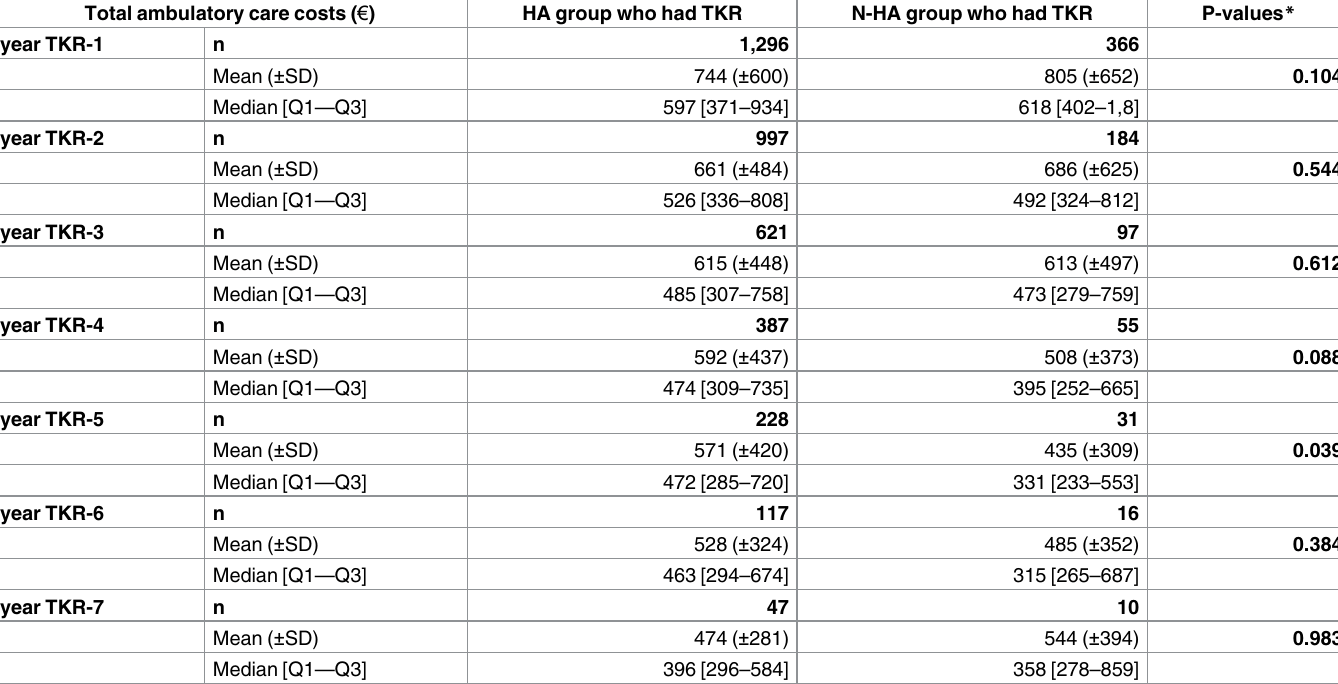
Table 5. Total ambulatory care costs per year from 1 to 7 years before TKR by treatment